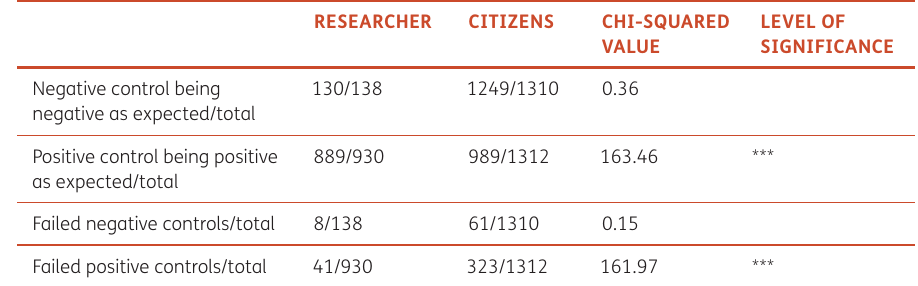
Table 1 Chi-squared test of difference in proportions of negative and positive control tests, performing as expected and failing to perform as expected, between researcher and